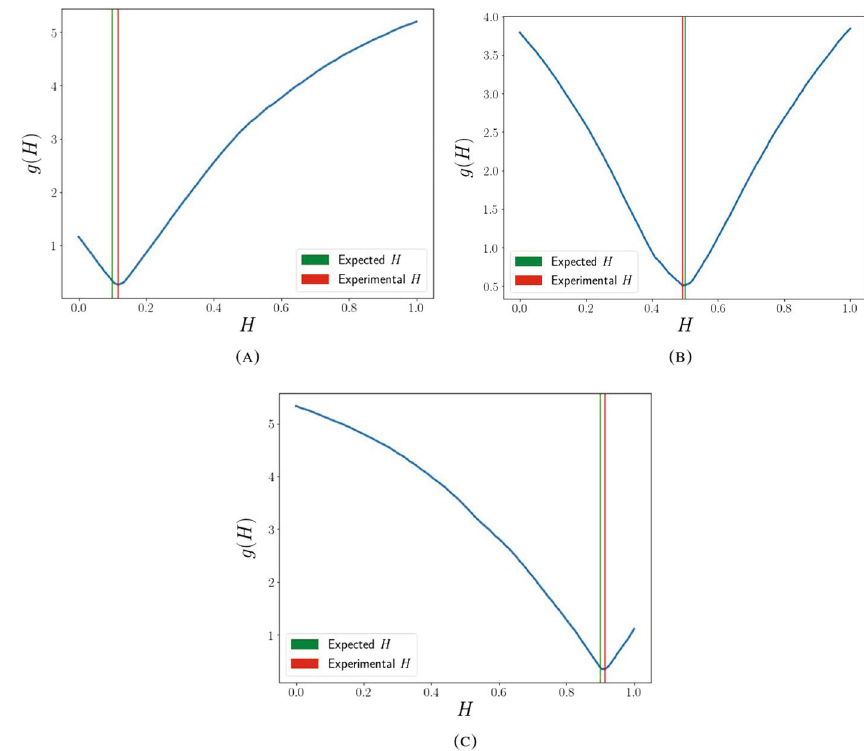
Fig. 2 Graphs of functions g between H = 0 and H = 1 with the KS‑GHE(1) method for a fractional Brownian motion with size 2 10 . The Hurst exponents are A 0.1, B 0.5, and C